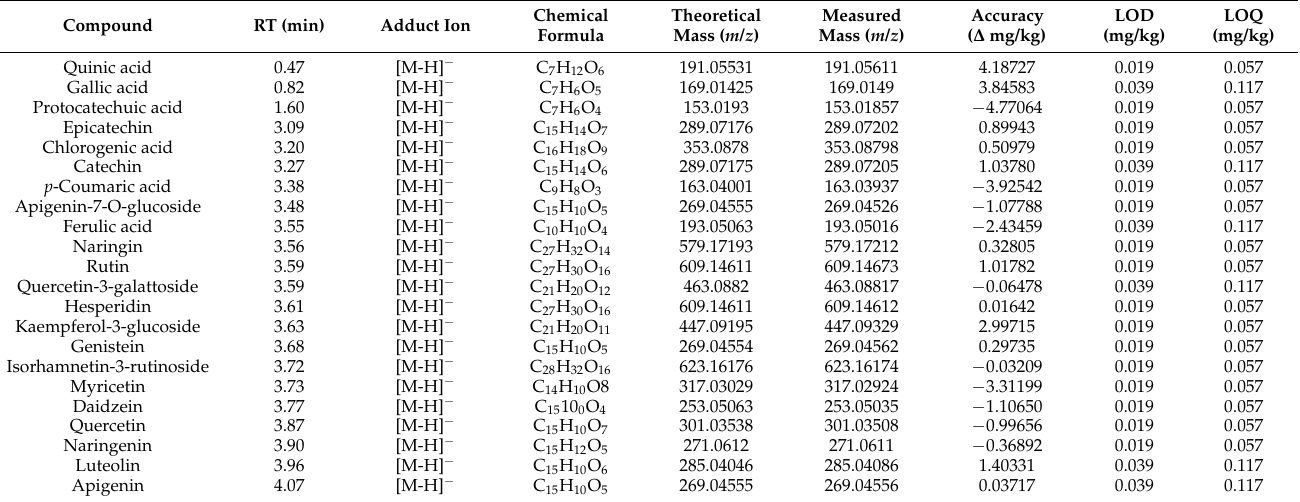
Table 1. UHPLC–HRMS parameters of the investigated